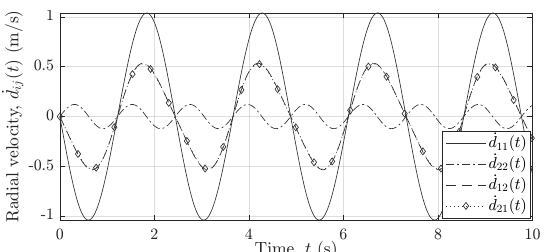
Figure 7. Analytical radial velocity components ˙ d ij ( t ) for the channel links A T x